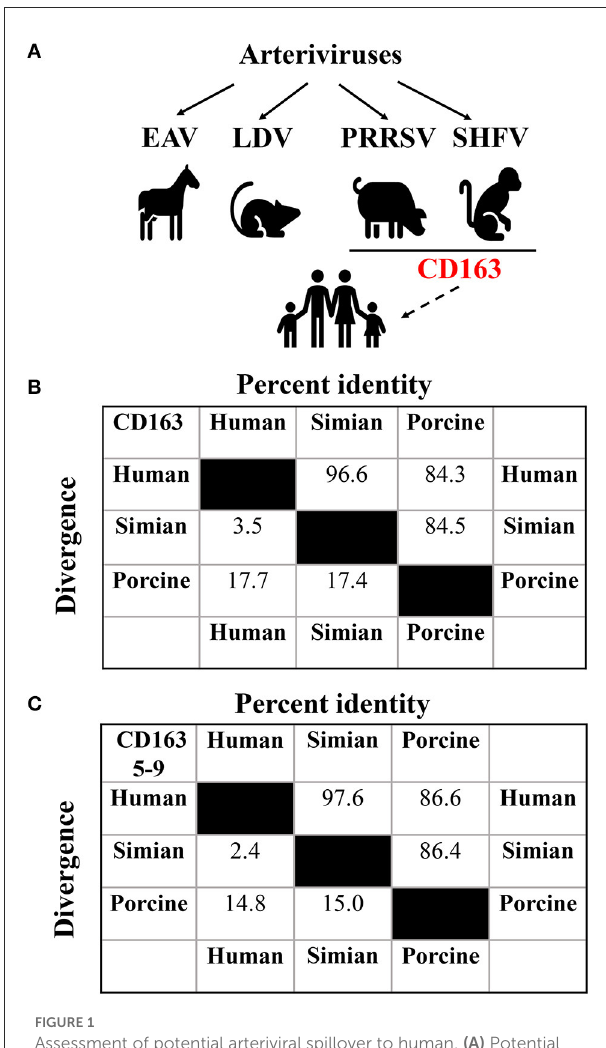
FIGURE1 Assessment of potential arteriviral spillover to human. (A) Potential cross-species transmission of arteriviruses. The solid lines indicate documented transmission, while the dashed one indicates potential transmission. The putative generic receptor CD163 for SHFV and PRRSV spillover to human is highlighted in red. (B) Analysis of the sequence identity among human (UniProt entry Q86VB7), simian (UniProt entry Q2VLG4), and porcine (UniProt entry Q2VL90) CD163 using CLUSTAL W method of DNASTAR Lasergene software (Madison, USA). (C) Analysis of the sequence identity among human, simian, and porcine CD163 SRCR5-9 using CLUSTAL W method of DNASTAR Lasergene software as described in (B)